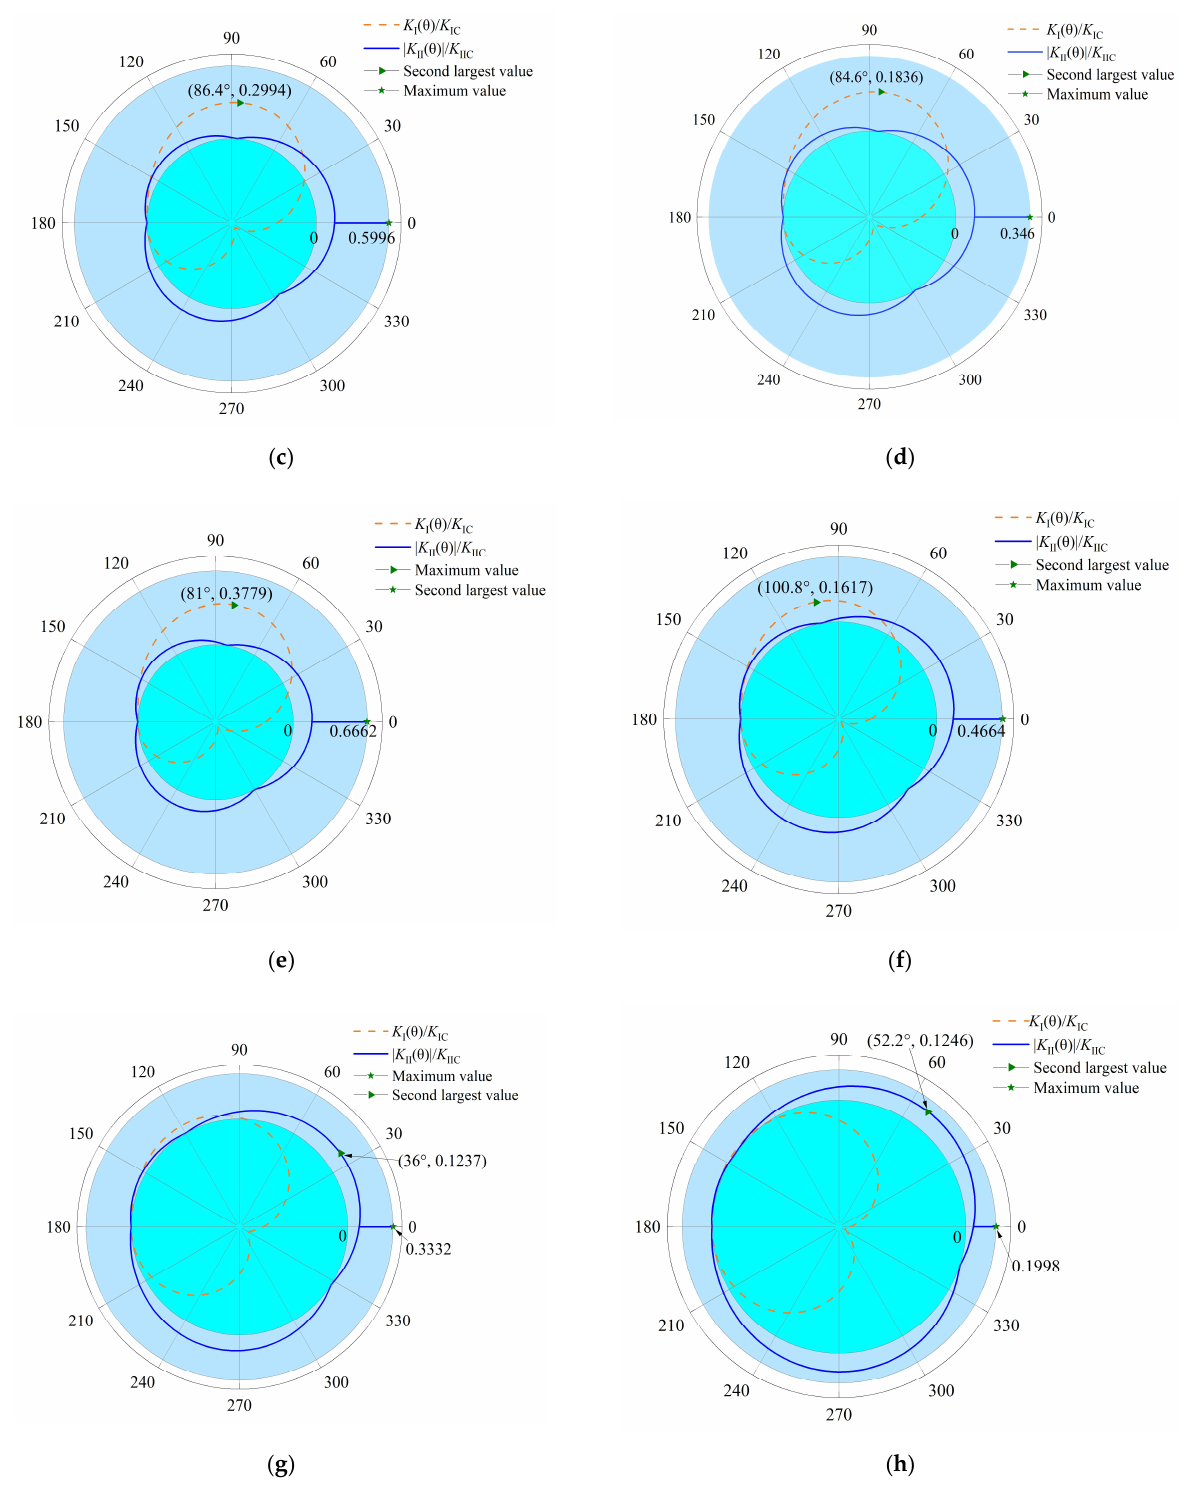
  K K  Figure 2. Variation in K I ( θ ) / K I C and | K II ( θ ) | / K II C under compression-shear loading. ( a ) k = 0.1 Figure 2. Variation in      and   under compression-shear loading. ( a ) k = 0.1 β C C K K β = 30 ◦ , ( b ) k = 0.1 β = 45 ◦ , ( c ) k = 0.1 β = 60 ◦ , ( d ) k = 0.1 β = 75 ◦ , ( e ) β = 60 ◦ k = 0, ( f ) β = 60 ◦ k = 0.3, = 30°, ( b ) k = 0.1 β = 45°, ( c ) k = 0.1 β = 60°, ( d ) k = 0.1 β = 75°, ( e ) β = 60° k = 0, ( f ) β = 60° k = 0.3, ( g ) β = 60° k = 0.5, ( h ) β = 60° k = 0.7. ( g ) β = 60 ◦ k = 0.5, ( h ) β = 60 ◦ k =